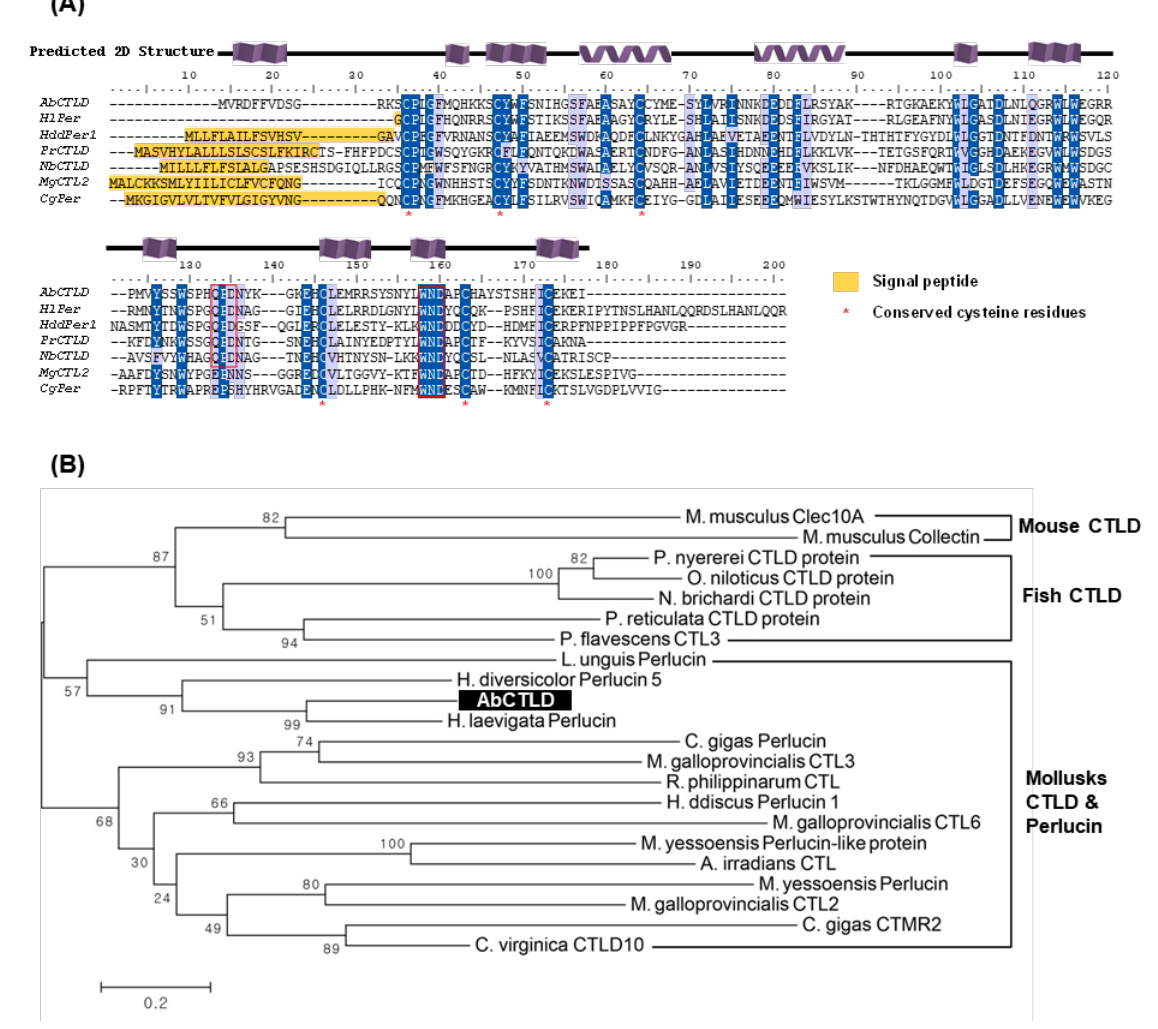
Figure 2. Analysis of the AbCTLD amino acid sequence. ( A ) Multiple alignment of the amino acid sequences of Pacific abalone C-type lectin (AbCTLD) and CTLDs in other mollusks and fish. Particular characteristics of the C-type lectin domains, including two predicted alpha helices and six conserved cysteine residues, are indicated. The aligned amino acid sequences are in greenlip abalone Haliotis laevigata perlucin (HlPer, P82596), guppy Poecilia reticulata (PrCTLD, A0A3P9N573), Pacific oyster Crossostrea gigas perlucin (CgPer, K1QRE6), Fairy cichlid Neolamprologus brichardi CTLD (NbCTLD, A0A3Q4MIS0), Haliotis discus discus perlucin 1 (HddPer1, ABO26590.1), and Mediterranean mussel Mytilus galloprovincialis CTL2 (MgCTL2, AJQ21493.1). Conserved amino acids are highlighted. ( B ) Construction of a neighbor-joining tree, based on the amino acid sequences of CTLDs from mollusks and teleosts. Mouse CTLD sequences were included as outgroups; bootstrap values are indicated for each node.